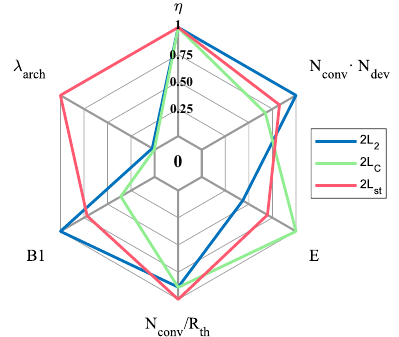
Figure 17. Normalized comparative analysis among the designed 2L 2 , 2L C , and 2L st architectures.